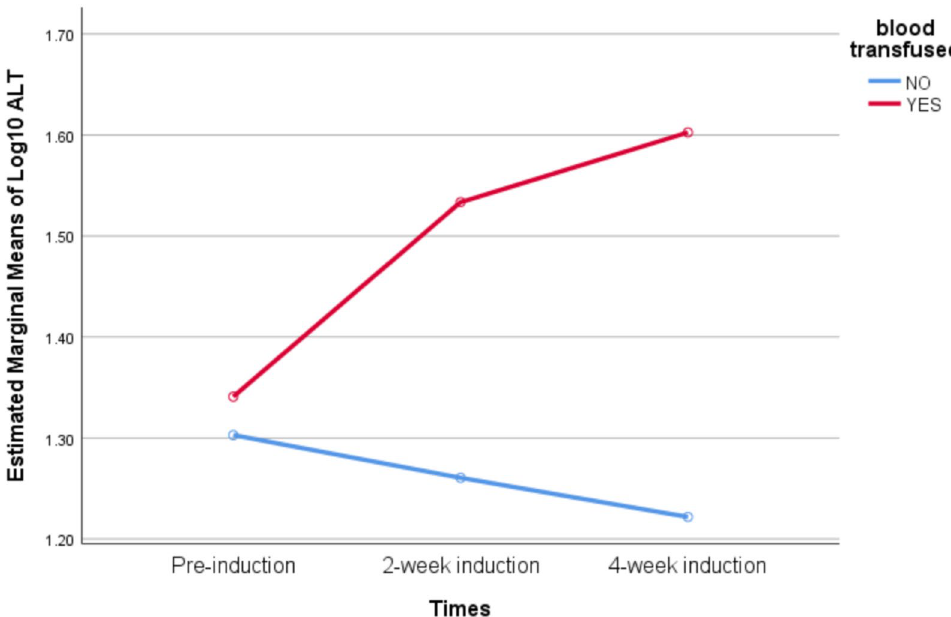
Figure 1. Depicts the interaction nature of ALT levels in patients with and without blood 465 transfusion during the induction period.